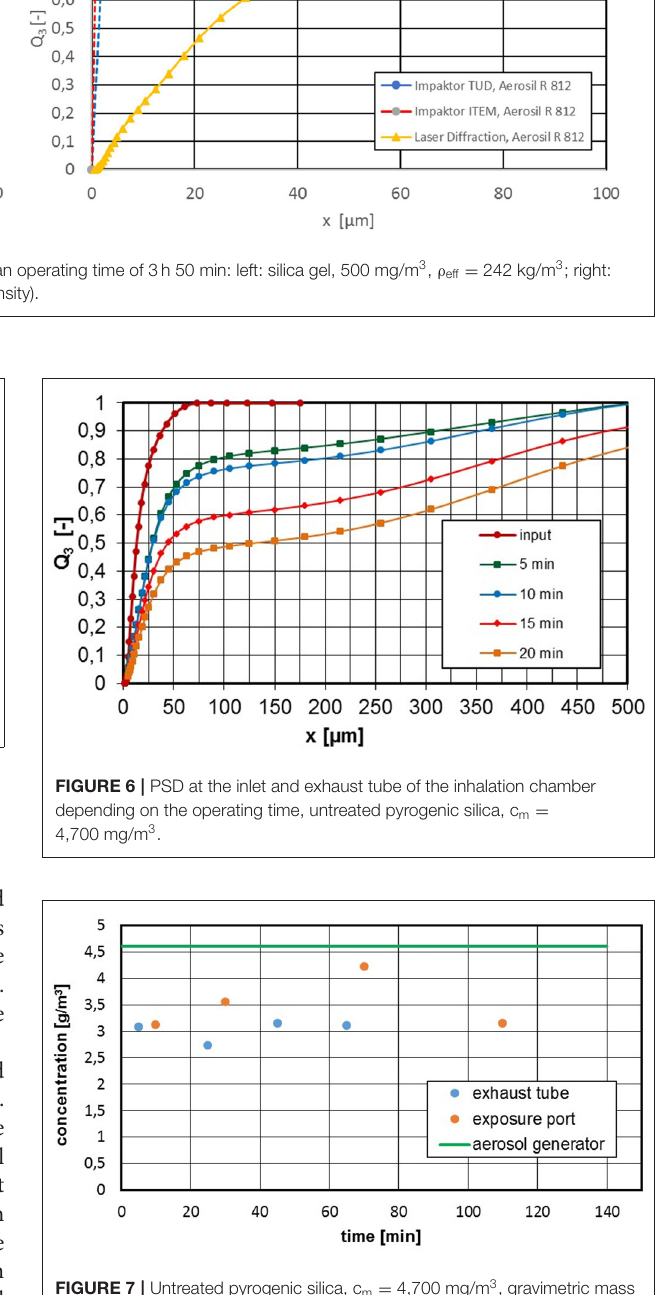
after 5-min operating time. According to the OECD max , the permissible fraction > 100 µ m would be about 5%. After 20-min operating time, this proportion increases further to >